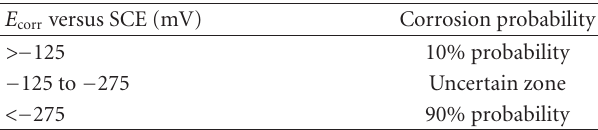
Table 1: Corrosion probability.